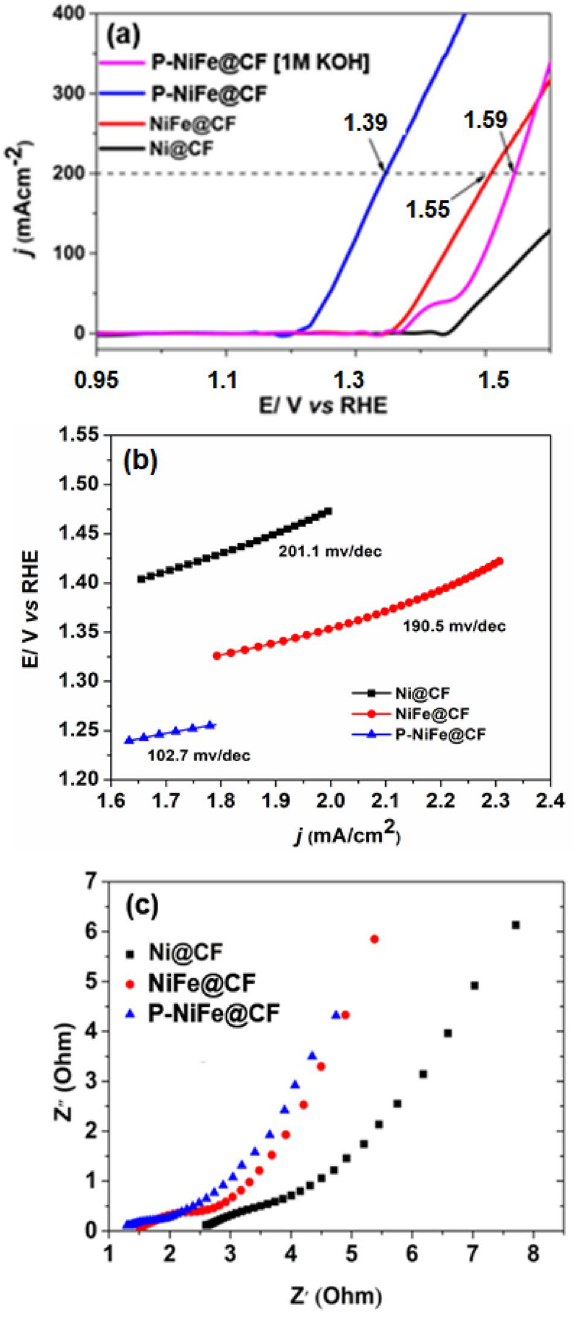
Figure 3. ( a ) LSV curves of Ni@CF, Ni–Fe@CF, and P-NiFe@CF in absence and presence of 0.33 M urea in 1.0 M KOH; ( b ) Tafel plots of different catalyst electrodes; and ( c ) Nyquist plots of different electrodes in 1.0 M